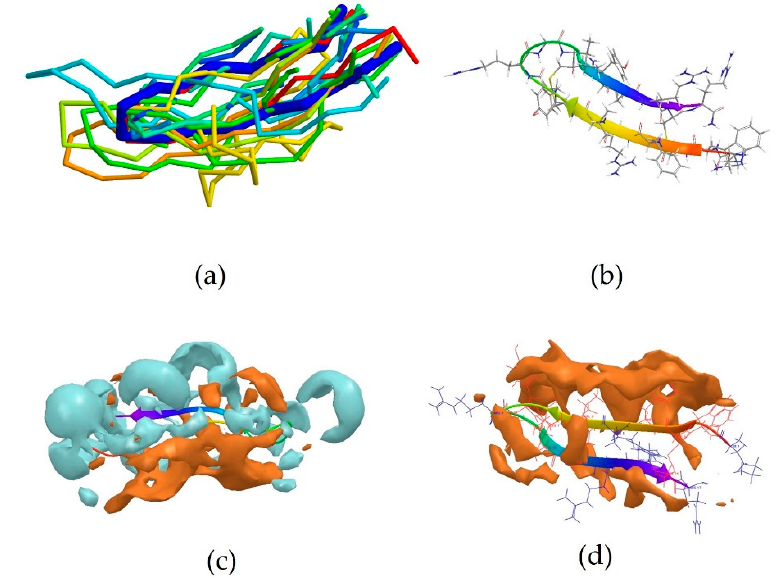
Figure 3. ( a ) Peptides populating cluster 3 superimposed onto the backbone of the centroid 2RTV (thick blue trace). No member of this cohort presented an α -helix arrangement; ( b ) Experimentally-derived 3D conformation of the centroid 2RTV; ( c ) The hydrophobic (amber) and hydrophilic (blue) regions on the surface of 2RTV are shown. It can be observed that Tachyplesin I displays a predominantly hydrophilic nature; ( d ) Detail of the hydrophobic region.